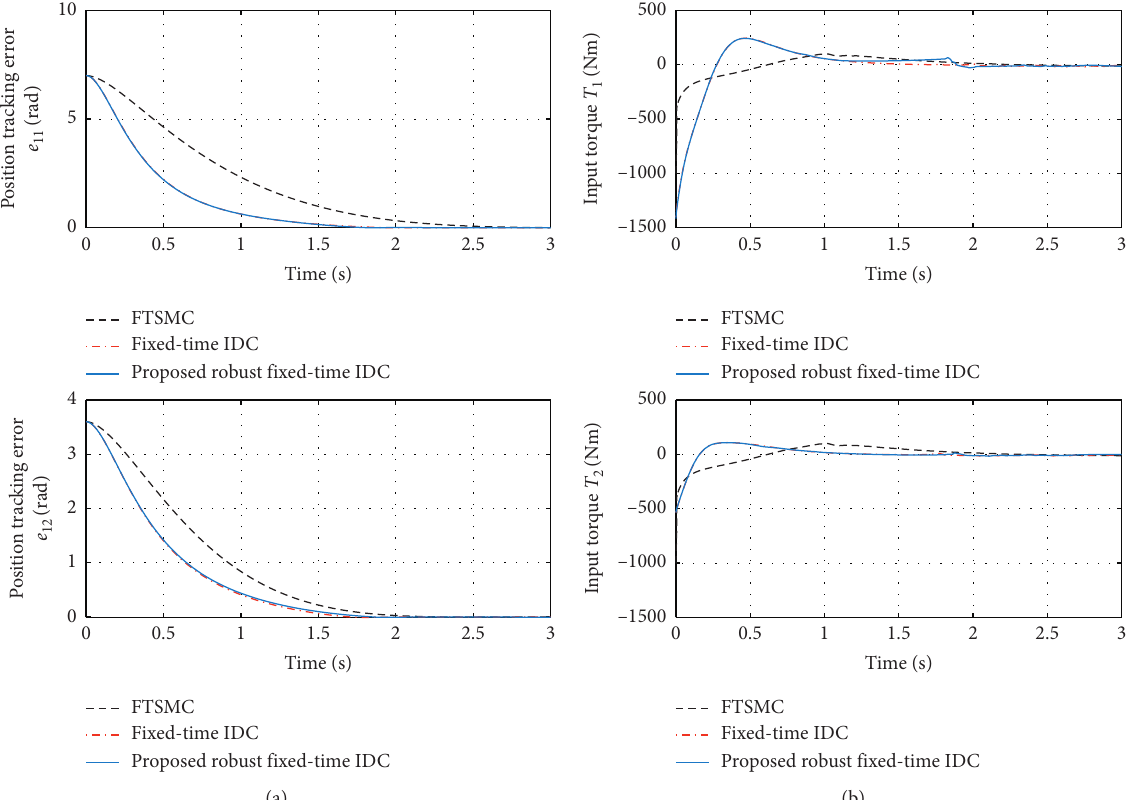
Figure 2: Responses of large initial condition in case 1 ( q ( 0 ) � [ 6 , 2 ] T rad ) . (a) Position tracking errors. (b) Input